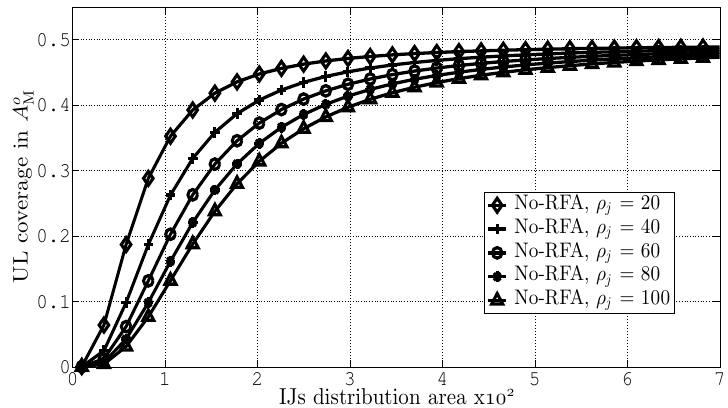
Figure 6. UL coverage against radius for IJs distribution area, without employing RFA.